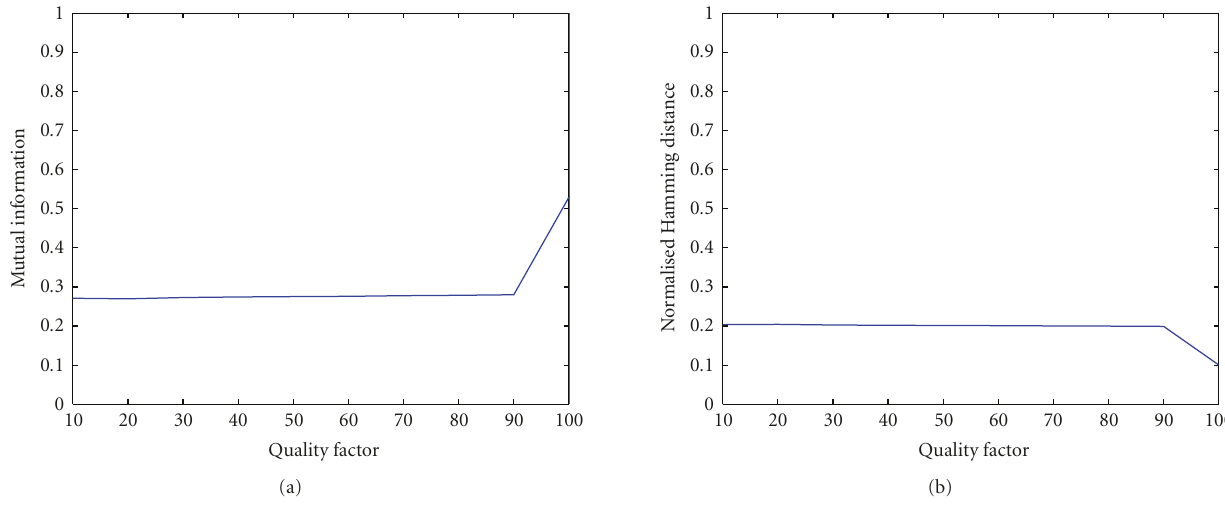
Figure 13: Detector response to JPEG compression attack: (a) mutual information; (b) normalized Hamming distance.